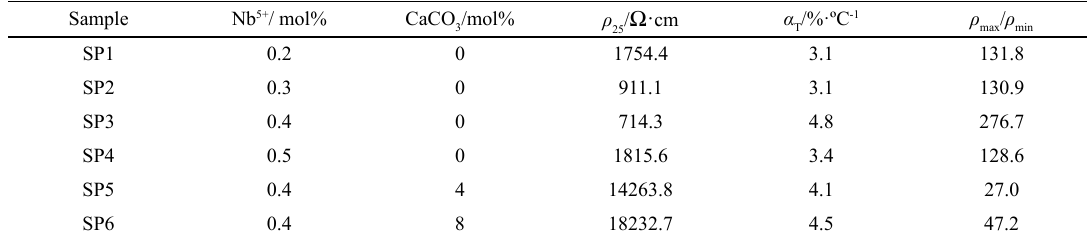
Table 1. The electrical properties and the resistivity jumping ratio of the BSTN samples